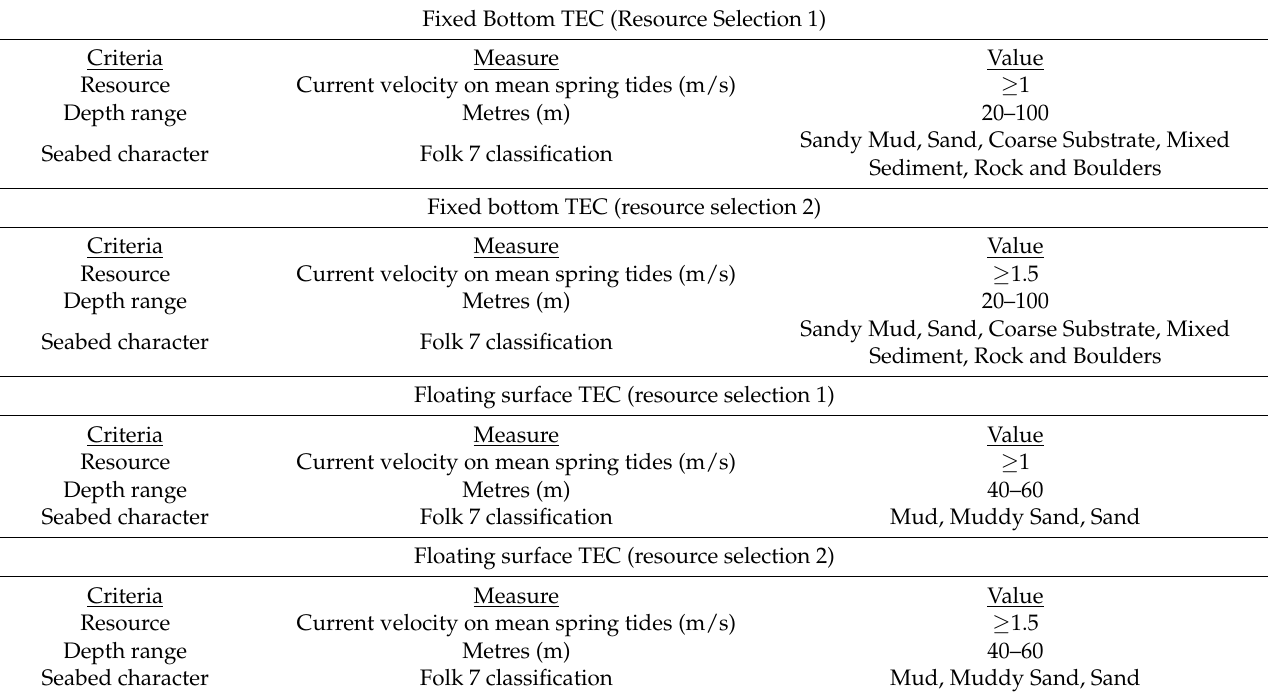
Table 8. Details of tidal site selection inputs based on technology developer survey responses.